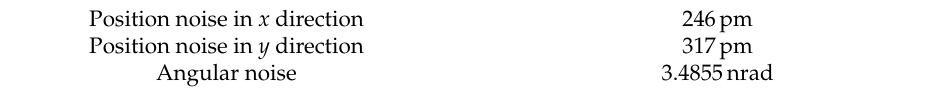
Figure 6. Positioning noise of the NFM-100 of the x and y interferometer (left y axis) as well as of the angle interferometer (right y axis) in closed-loop control for a duration of 10 s at the origin (0,0). Table 2. Different values of positioning noise (1 σ ) in closed-loop control of the NFM-100 for a duration of 10s and a sampling frequency of 10kHz (see Figure 6).